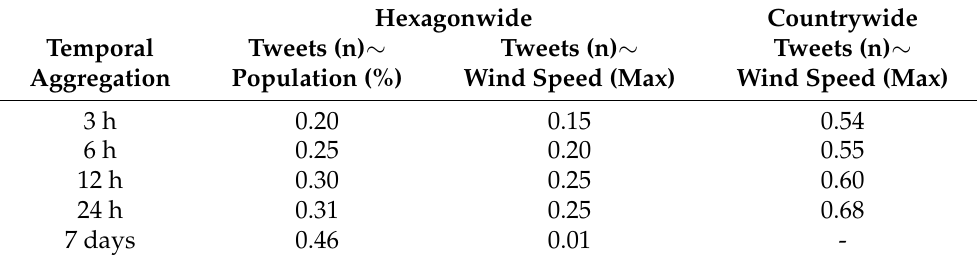
Table 2. Determined correlation coefficients ( p ≤ 0.0001) for multiple temporal aggregation and spatial allocations.